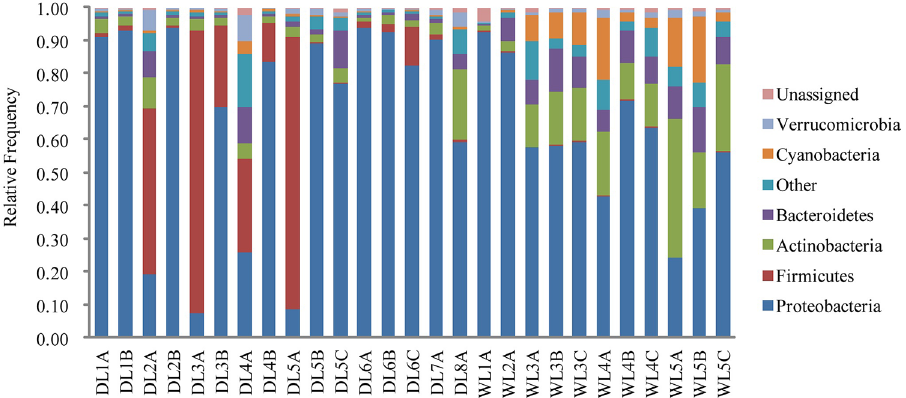
Figure 5. The phyla relative abundances of bacterioplankton communities in WL Reservoir and DL Reservoir. Phyla with relative abundances < 0.1% in all samples were grouped as ‘other